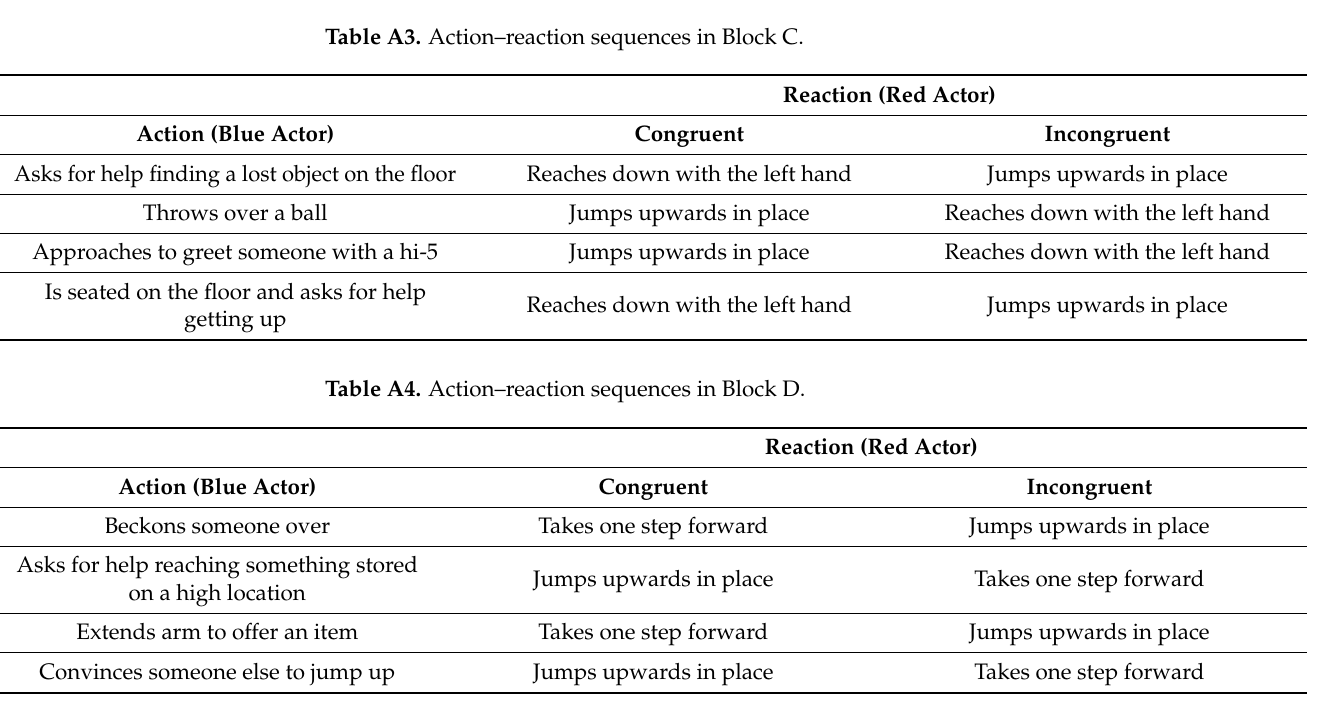
Table A5. Action–reaction sequences in Block E.